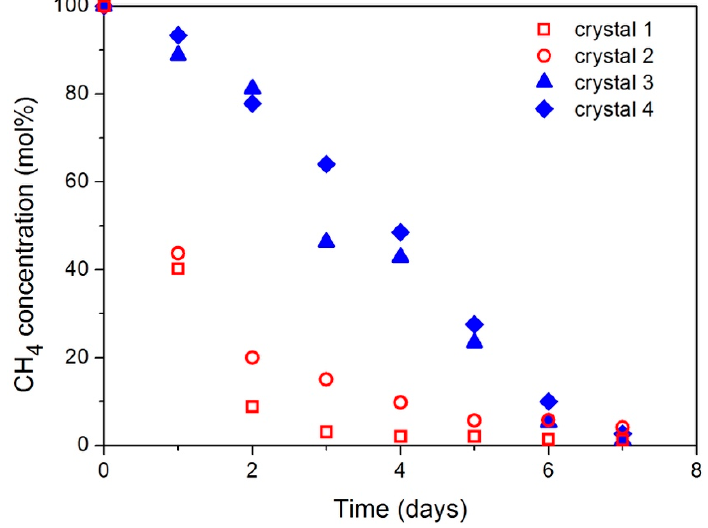
Figure 10. Changes in CH 4 concentration on the surface of the hydrate crystals over time. Crystals marked in blue experienced a clear decrease regarding their size while those marked in red either grew or maintained their size.